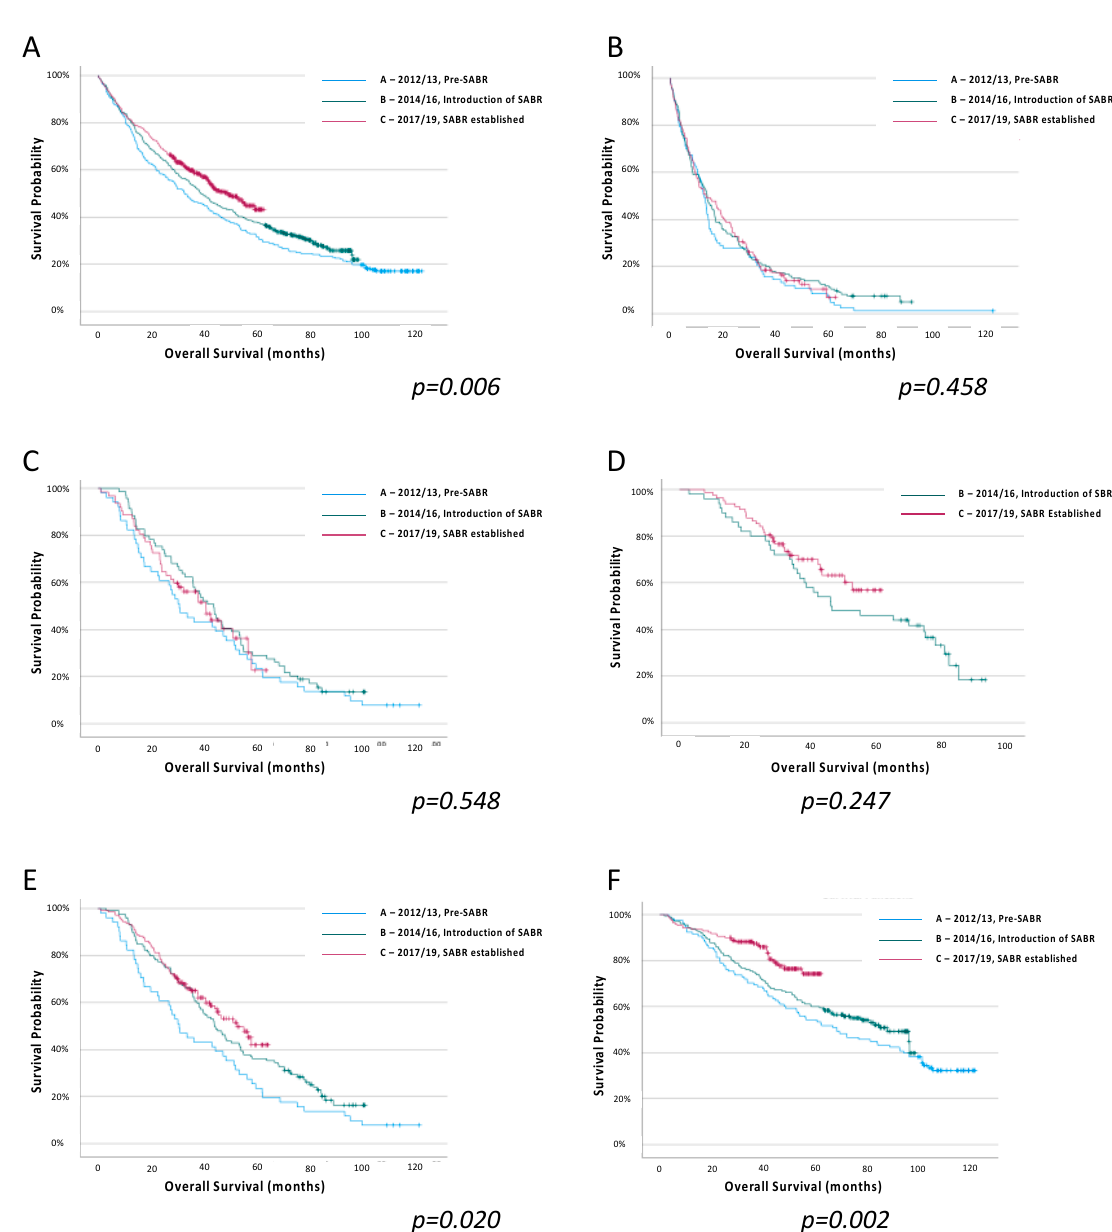
Figure 2. Overall survival estimates for all patients with stage I NSCLC, and for each treatment group, by treatment time period, ( A ) All patients, ( B ) No radical therapy, ( C ) Conventional radical radiotherapy, ( D ) SABR, ( E ) Any radical radiotherapy (CRRT or SABR), ( F ) Surgery. Log-rank regression.